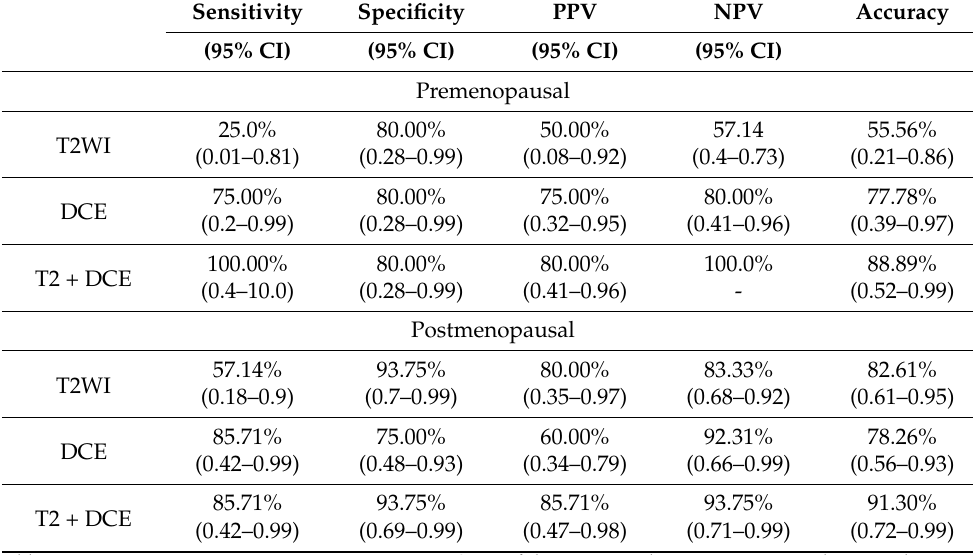
Table 4. Performance of the MRI (magnetic resonance imaging) sequences in determining the depth of myometrial invasion in pre- and postmenopausal